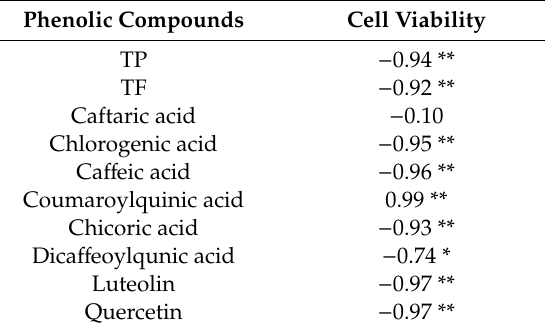
Figure 3. E ff ects of lettuce extracts ( A ) and pure individual phenolic compounds ( B ) on cell viability in Figure 3. Effects of lettuce extracts (A) and pure individual phenolic compounds (B) on cell viability Caco-2 cells. * indicates significant di ff erence at P < 0.05 between LP and CP. in Caco-2 cells. * indicates significant difference at P < 0.05 between LP and CP. Table 1. Correlation coe ffi cients (r) between the cell viability and phenolic profiles. The phenolic profiles are total phenolic content (TP), total flavonoids content (TF) and the individual phenolic compounds in lettuce